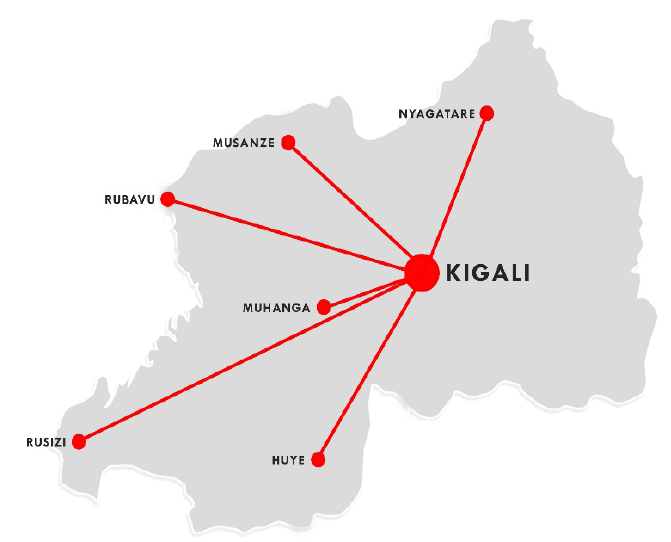
Figure 2. Proposed Satellite Regional Plan for Rwanda. Drawing by Manlio Michieletto.